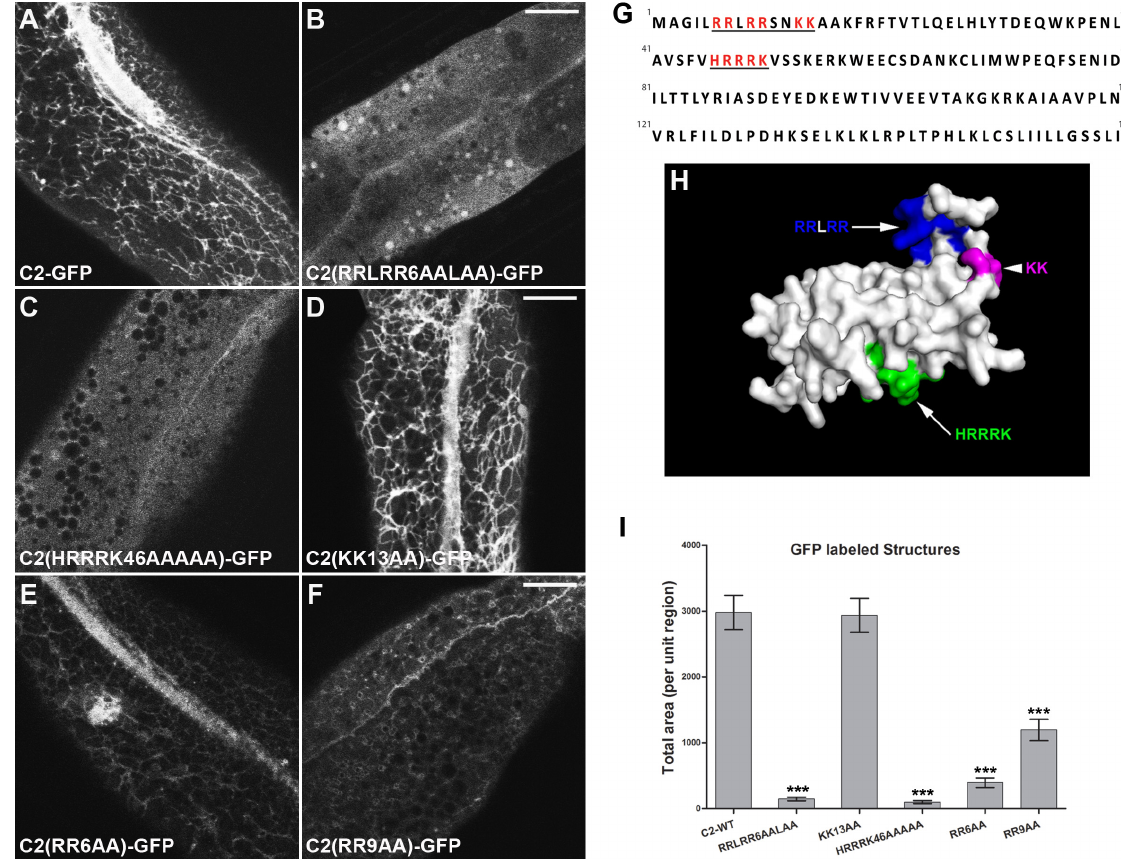
Fig 4. Basic residue patches RRLRR and HRRRK are both required for membrane association of EHBP-1 NT-C2 domain. (A) Wild-type EHBP-1(NT-C2)-GFP labels punctate and tubular endosomal structures. (B) Compared with the wild-type NT-C2 domain, EHBP-1(NT-C2:RRLRR6AALAA)-GFP lost endosomal association and appeared diffusive in the cytosol (~95% decrease in structures labeling). (C) Alanine substitutions of HRRRK caused cytosolic diffusion of NT-C2-GFP (~97% decrease in structure labeling). (D) EHBP-1(NT-C2:KK13AA)-GFP subcellular localization was not affected. (E-F) Loss of either RR6 or RR9 decreased labeling of EHBP-1(NT-C2)-GFP on endosomal structures (~87% and ~60% decrease respectively). (G) Annotated amino acid sequence of EHBP-1 NT-C2 domain (aa1-160). Basic residues are indicated by red, and the clusters are underlined. (H) Surface diagram of the EHBP-1 N-terminal (aa1-160) homology model (created via HHpred and modeler). RRLRR, indicated by blue, is located at the extreme N-terminus, contributing to a concavity formation together with surrounding hydrophobic residues. HRRRK, indicated by green, is located at the other side of the model surface. (I) Total area (per unit region) was quantified for GFP-labeled structures in (A-F) . Error bars are SEM (n = 18 each, 6 animals of each genotype sampled in three different regions of each intestine defined by a 100 x 100 (pixel 2 ) box positioned at random). Asterisks indicate significant differences in the one-tailed Student ’ s t-test ( *** p < 0.001). Scale bars represent 10 μ